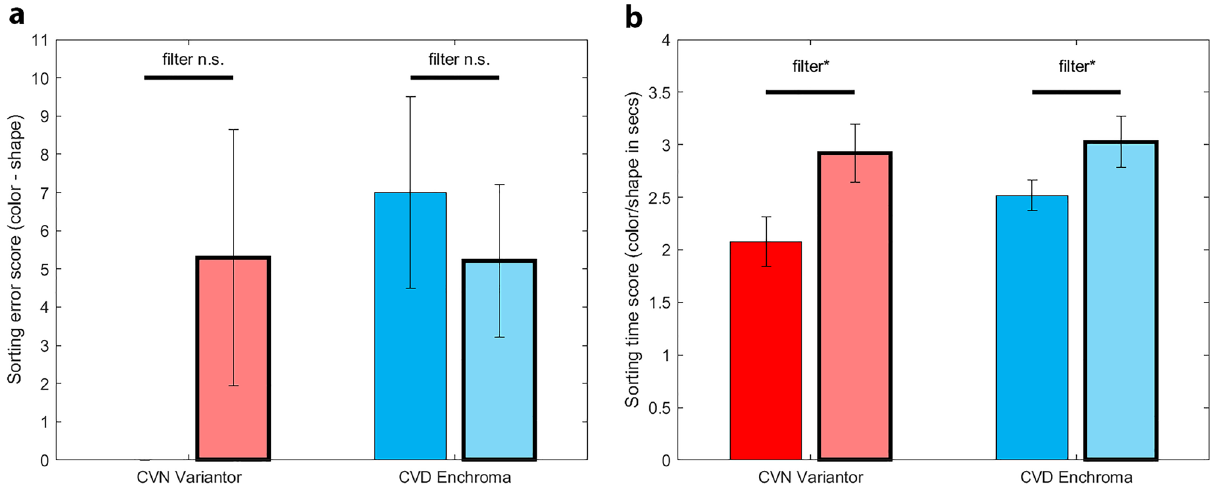
Figure 6. Mean sorting task error and timing results, with and without filters. Average difference between colour and shape error scores ( a ) and average proportion between colour and shape time scores ( b ) on the sorting task for the CVN-Variantor (red bars) and the CVD-EnChroma (blue bars) not using (solid with skinny border) and using (translucent with thick border) the filter in the sorting task. Error bars show standard error of the mean (SEM). *(P < 0.05) and n.s. (no significant) indicate overall effects from the